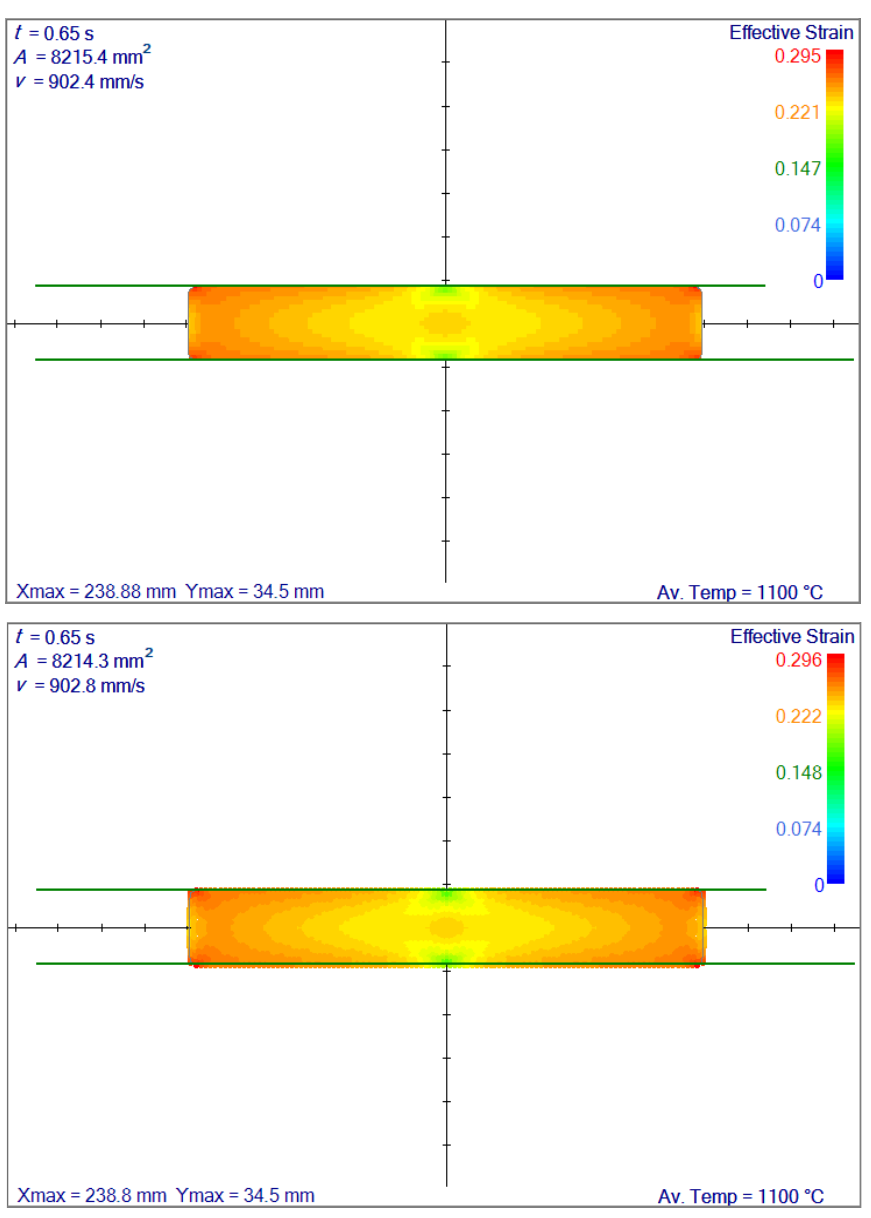
Figure 7. Comparison of effective strain fields after 10.5 mm of reduction. Av. Temp. stands for average temperature.